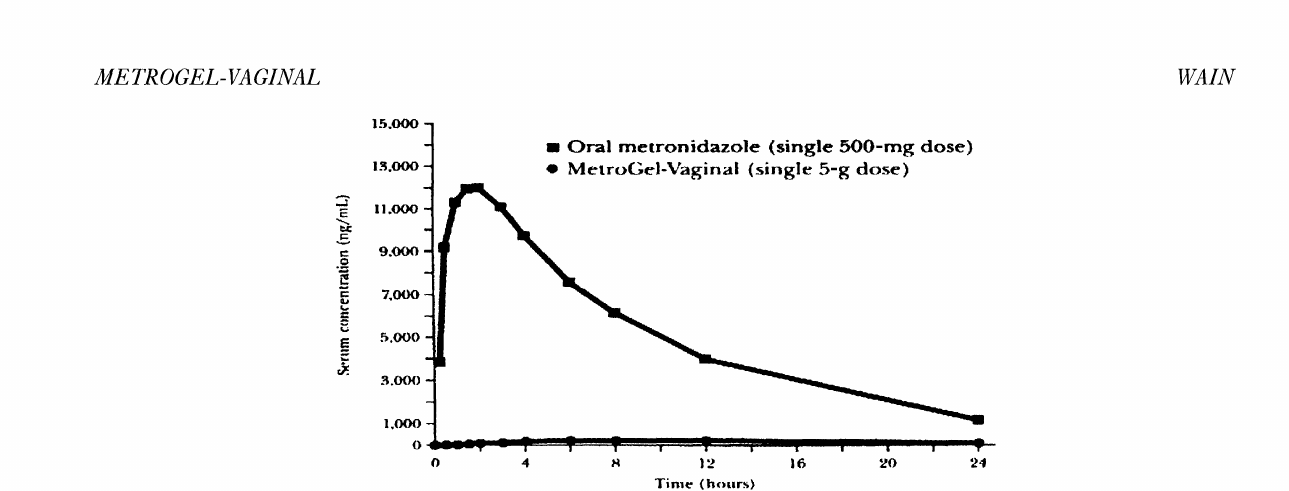
Fig. I. Mean serum concentrations of metronidazole over time following a single 5-g intravaginal dose of 0.75% metroni- dazole gel or a single 500-mg oral dose of metronidazole in 12 normal, healthy volunteers. MetroGeI-Vaginal produces only 2% of the mean peak serum concentration of a standard oral metronidazole